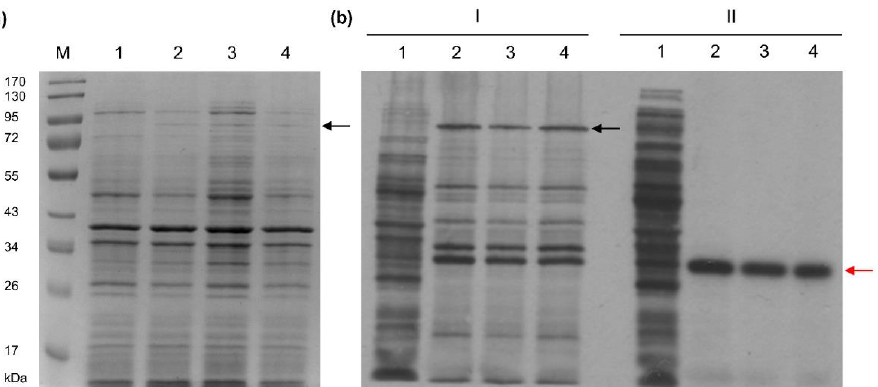
Figure 3. Overproduction of the Tt72 pol in E. coli BL21(DE3)[pRARE, pET15b_polTt72] cultivated at 30 ◦ C. ( a ) SDS-PAGE (10%) of cellular proteins from 150 µ L samples of E. coli BL21(DE3)[pRARE, pET15b_polTt72]: lane 1, before induction; lanes 2–4, after induction (60, 90, and 120 min respectively); 1 mM IPTG; lane M, protein molecular mass markers (PageRuler TM Prestained Protein Ladder, Thermo Scientific). The gel was stained with Coomassie Brilliant Blue R-250. ( b ) Autoradiogram of proteins pulse-labeled in vivo with [ 35 S]-methionine and separated on SDS-PAGE (10%). A hundred and fifty µL samples of cultures were labeled for 5 min with 2.5 µCi [ 35 S]-methionine at 30 °C. (I) E. coli BL21(DE3)[pRARE, pET15b_polTt72]: lane 1, before induction; lanes 2–4, after induction (1 mM IPTG): 2 (60 min), 3 (90 min), and 4 (120 min). Rifampicin was added to a 200 µg/mL concentration 30 min after induction. (II) E. coli BL21(DE3)[pRARE, pET15b] (negative control): lanes 1–4 correspond to the treatment described in subpanel I. The Tt72 pol and β -lactamase positions are indicated by the black and red arrows, respectively.